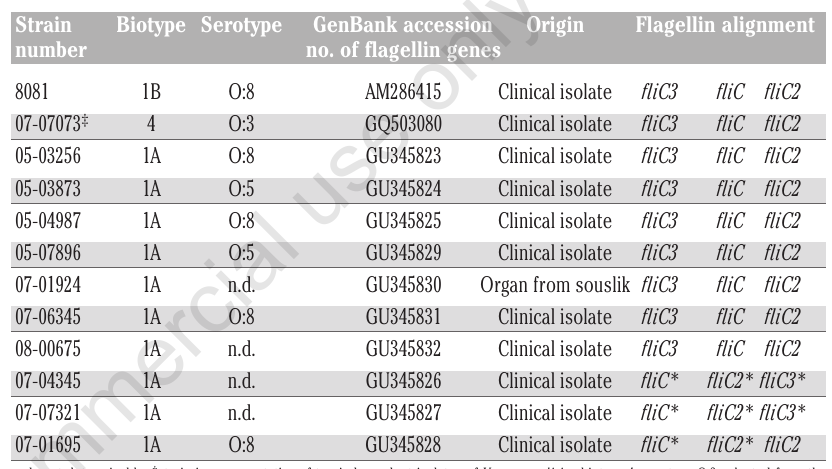
Table 1. Yersinia enterocolitica